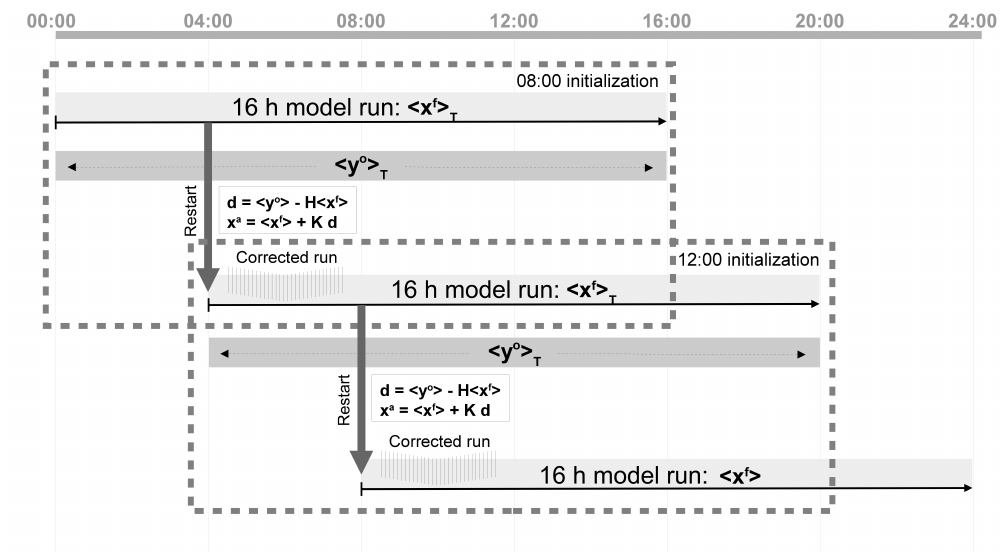
Figure 11. Data assimilation cycle in Oke et al. (2002). The time-distributed averaging procedure approach used to initialize the problem at time T/ 2 uses all the observations in the period [ 0 ,T ] . In their application, the time T is approximately the inertial